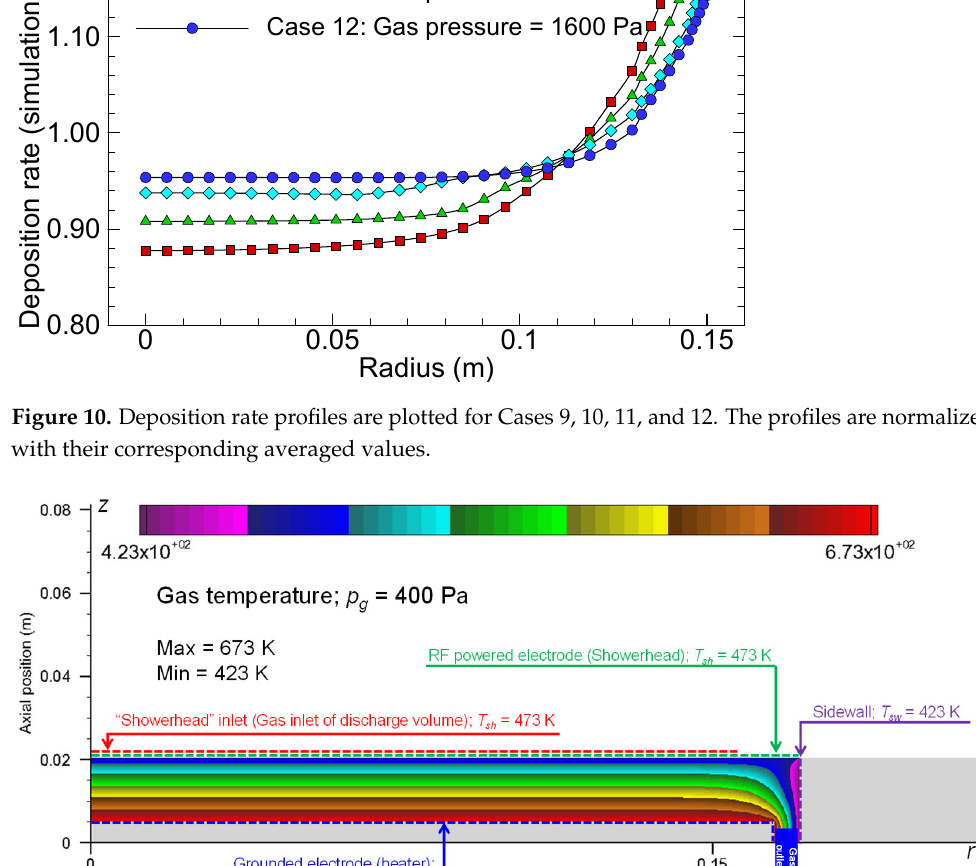
Figure 11. Schematic diagram of the modified CCP reactor. Spatial variation in the gas temperature ( T g , K) is depicted for Case 13.